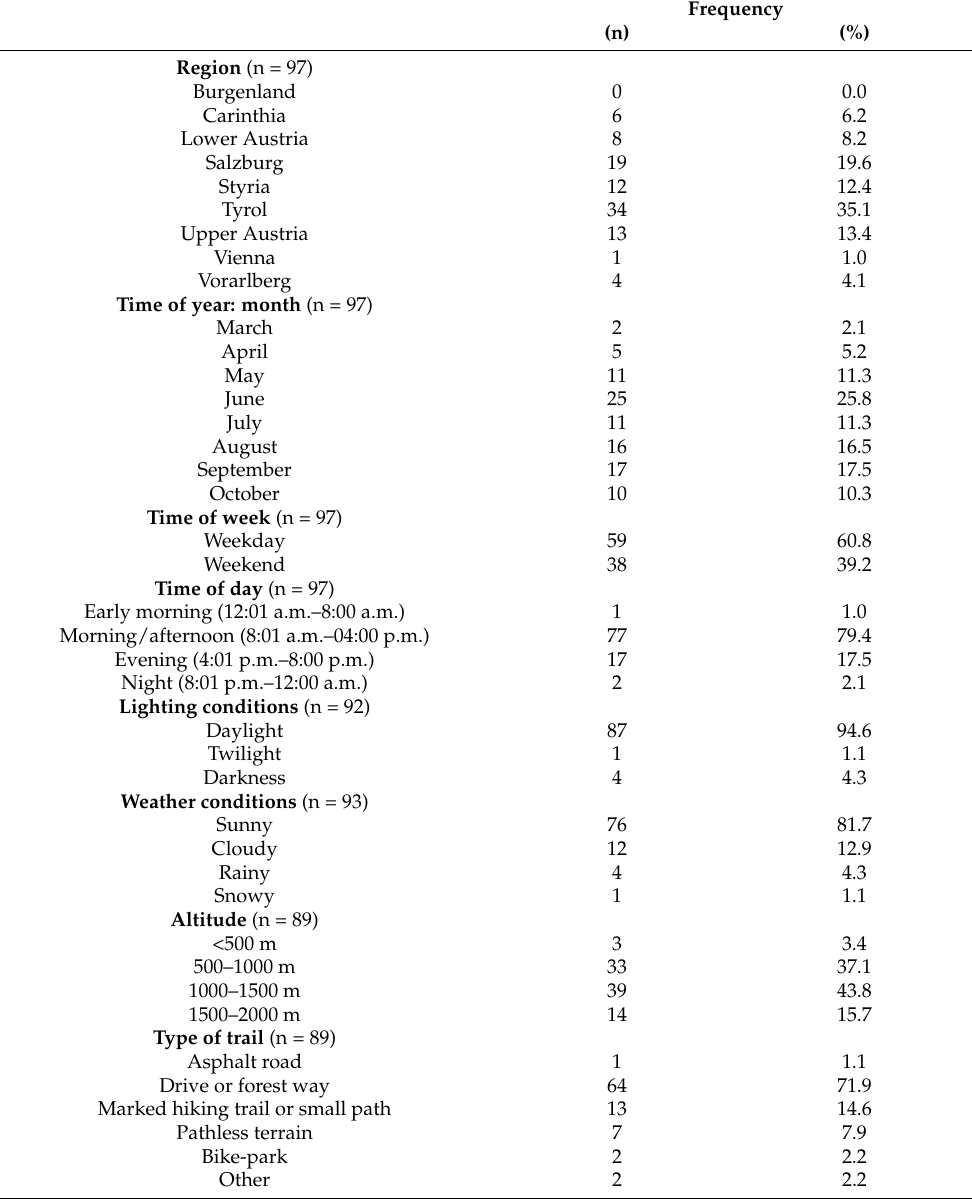
Table 1. Environmental characteristics associated with fatal accidents of recreational mountain- bikers in the Austrian Alps during the period 2006–2021. Data are presented as absolute and relative